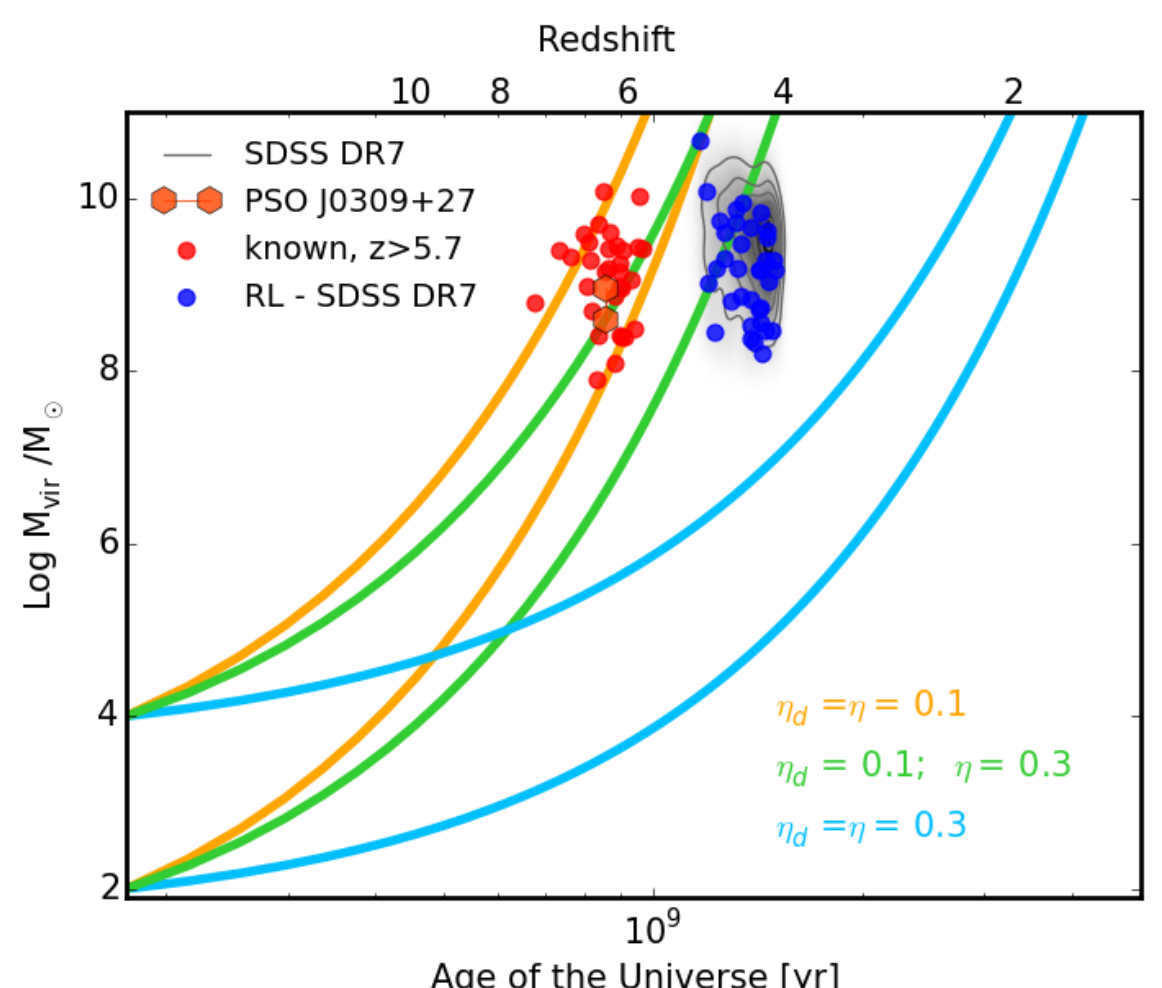
Figure 2. Black hole mass evolution as a function of the age of the Universe. Red points are the known quasars with virial-based mass measures at z > 5.7. The hexagons show the mass range of the highest- z blazar known [16]. The grey contours show the whole SDSS DR7 quasar sample, including the few tens of radio-loud sources (blue points). The solid lines show the Eddington-limited evolution based on the Salpeter timescale, starting from two different black hole seeds, and assuming that (i) the energy released during the accretion η coincides with the accretion disc radiative efficiency η d in the case of a Shakura–Sunyaev disk around a non-spinning black hole (yellow line), (ii) same but in the case of a maximally spinning black hole (green line), (iii) the black hole is maximally spinning and thus the energy release is η = 0.3, but only a fraction of it is radiated through the accretion disc (light blue